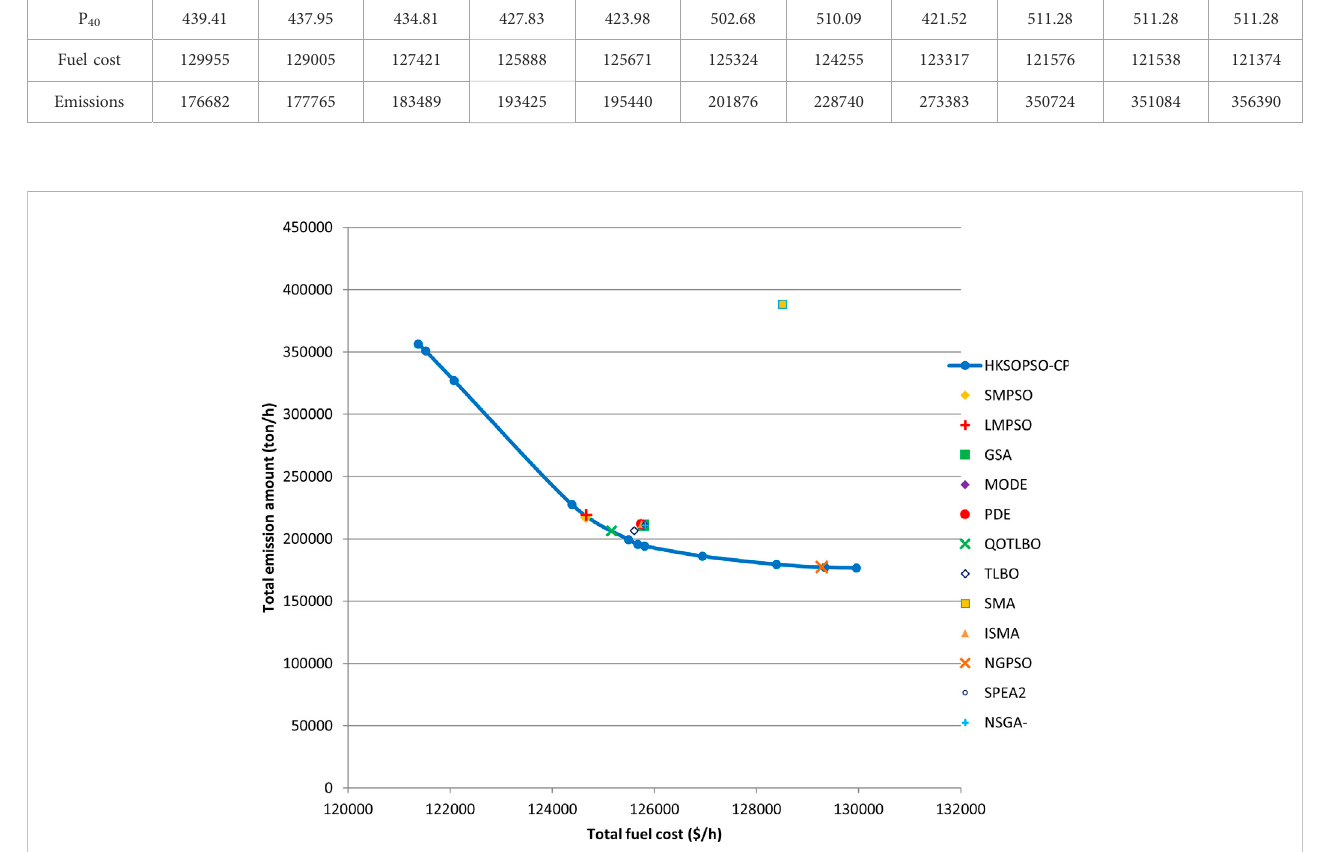
FIGURE 6 Case 3: Solutions generated by the HKSOPSO-CP algorithm, and the best compromise solutions provided by other